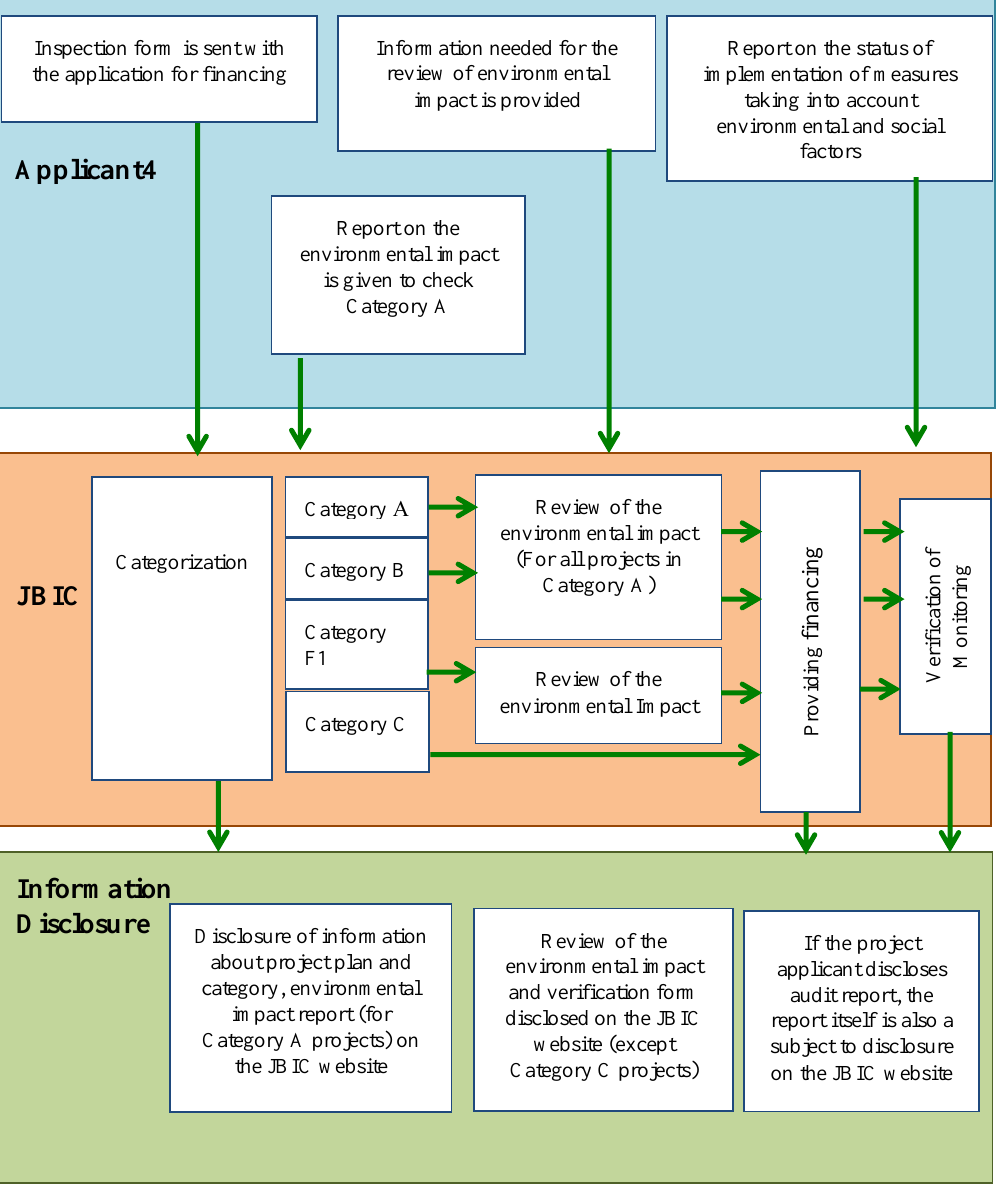
Fig. 3. The project evaluation process by Japan Bank for International Cooperation, taking into account social and environmental